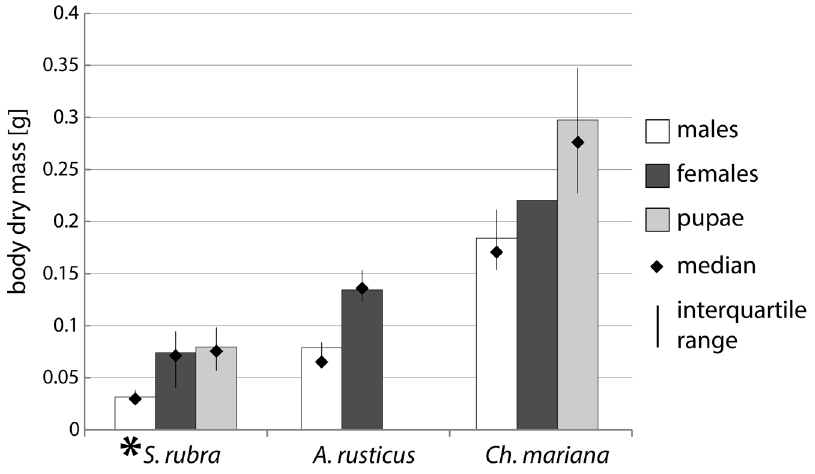
Fig. 1. Body sizes of the studied xylophagous beetles (dry mass, boxes 5 means). Significant differences between males and females are asterisked (Mann-Whitney U test, p , 0.05). Ch. mariana was not considered in significance testing (too few female